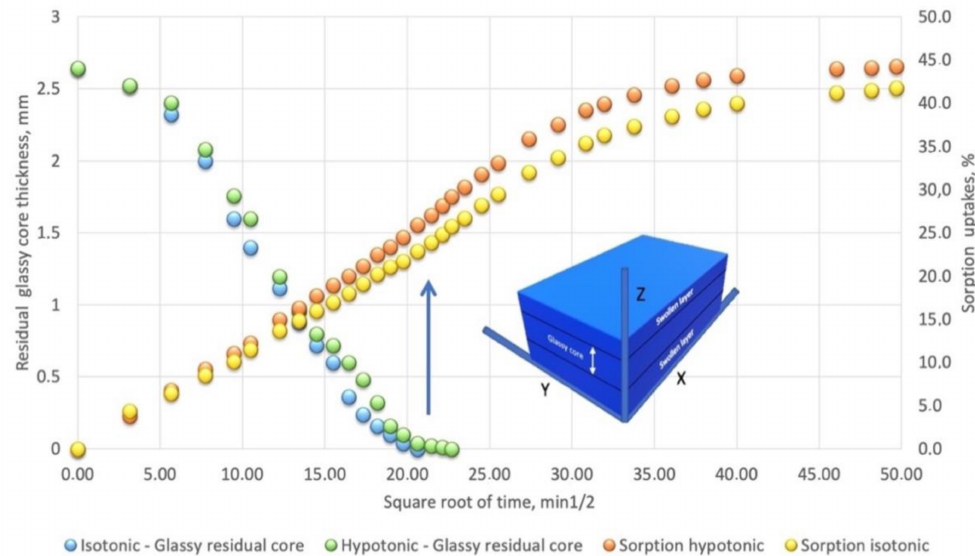
Figure 3. Swelling kinetics measured (left axis) as residual glassy core thickness and anomalous sorp- tion behavior (right axis) in initially glassy 5% by volume nanosilica-loaded PHEMA nanocomposite equilibrated in hypotonic and isotonic physiological